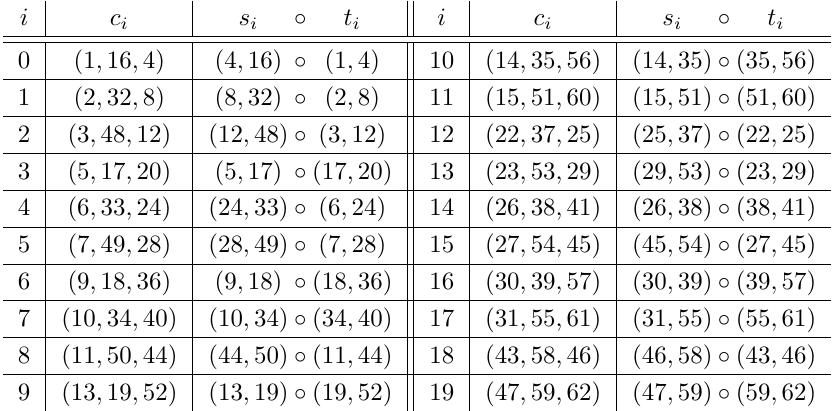
Table 2: Decomposition of the 3-cycle c i ’s into swaps for the PRESENT